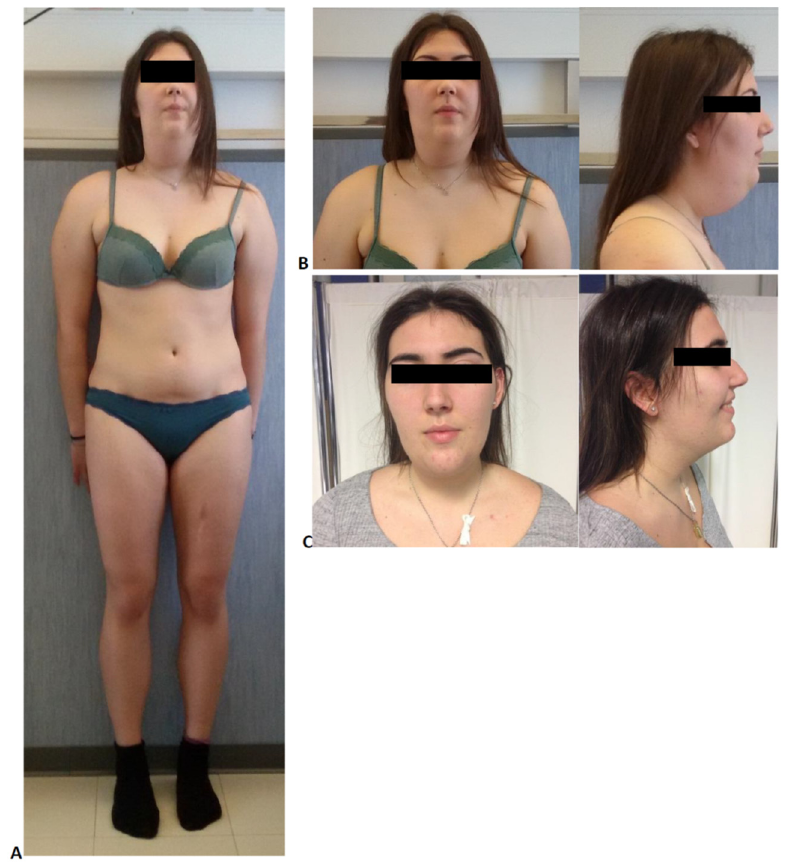
Figure 2. Pictures of the patient carrier of the heterozygous LMNA pR545H mutation. ( A , B ) Anterior and lateral view of the patient taken two years before (at age 17) plastic surgery intervention. Excess of fat over the shoulders and in the anterior regions of the neck along the jawline is evident without clear signs of lipoatrophy. ( C ) Anterior and lateral view of the patient taken one month after the plastic surgery intervention (liposuction).